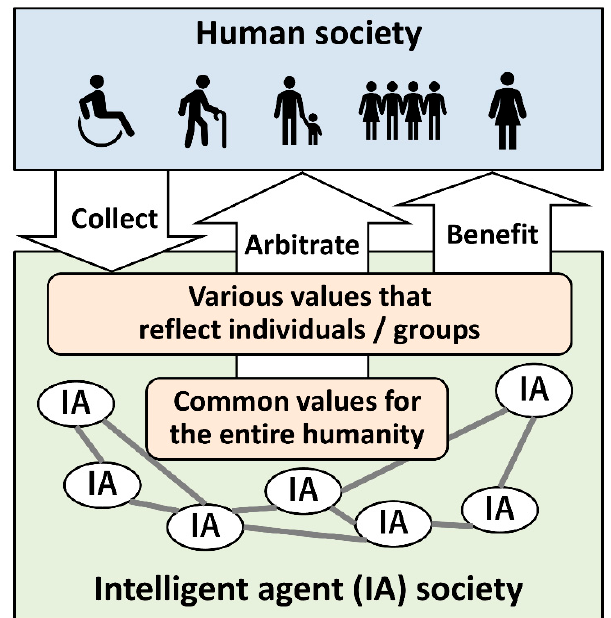
Figure 1. Example ecosystem consisting of human society and artificial intelligence (AI) society. Note: IA denotes intelligent agent which contains AI.